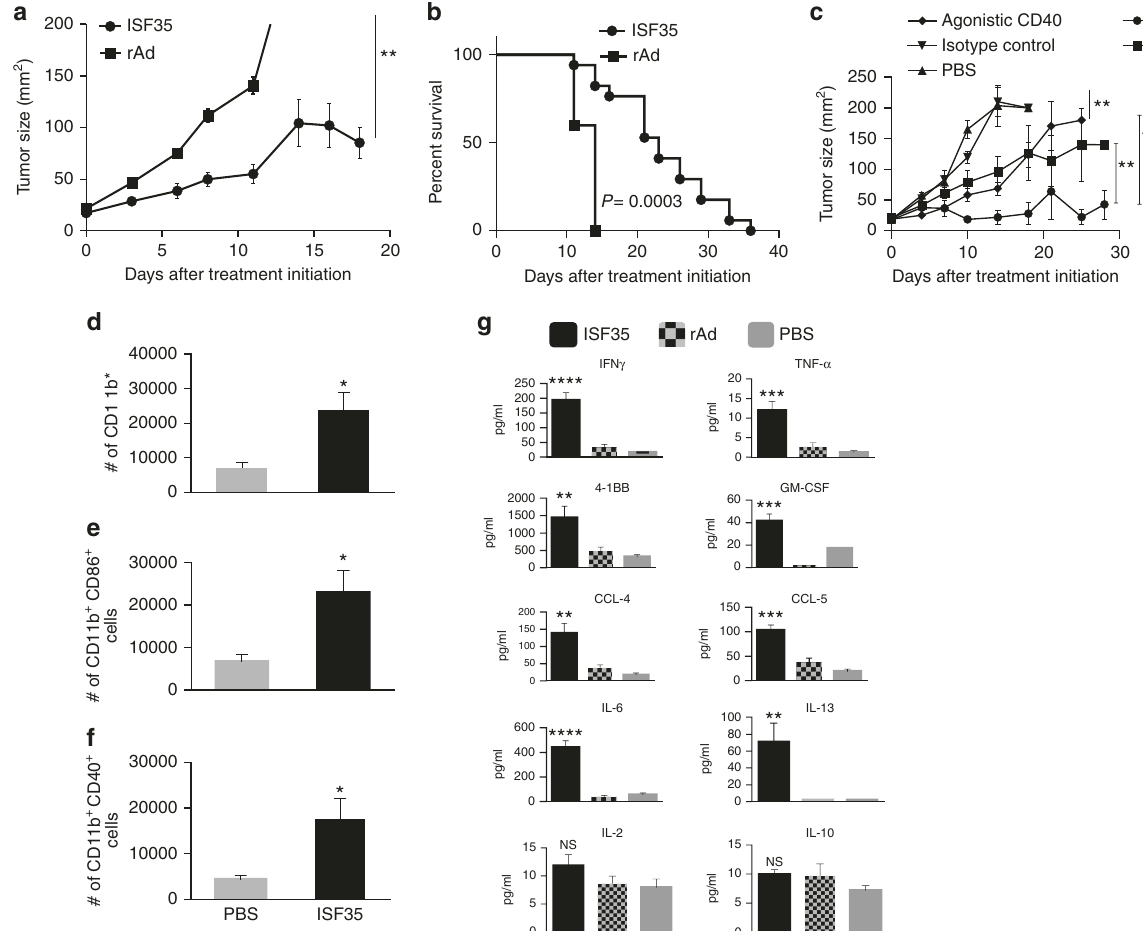
Fig. 1 Antitumor activity and immune response upon intratumoral ISF35 treatment. Mice bearing 8-day s.c. B16.F10 tumors were treated on day 0, 4, 8, and 12 with ISF35 or control rAd/PBS. a Tumor growth ( n = 10). b Mouse survival ( n = 10). c Tumor growth after i.t. treatment with agonistic CD40 mAb or ISF35 ( n = 8). d – f Myeloid cell numbers and activation in tumor 5 days after initiation of ISF35 or PBS treatment. g Intratumoral cytokines and chemokines 7 days after initiation of ISF35 or rAd or PBS treatment, measured by Luminex from a tumor supernatant ( n = 5). Data are representative of at least two independent experiments and analyzed by unpaired two-tailed t test or one-way ANOVA. * P < 0.05, ** P < 0.005, *** P < 0.0005 and **** P < 0.00005. Error bars are SEM. Survival analysis was performed with the log-rank